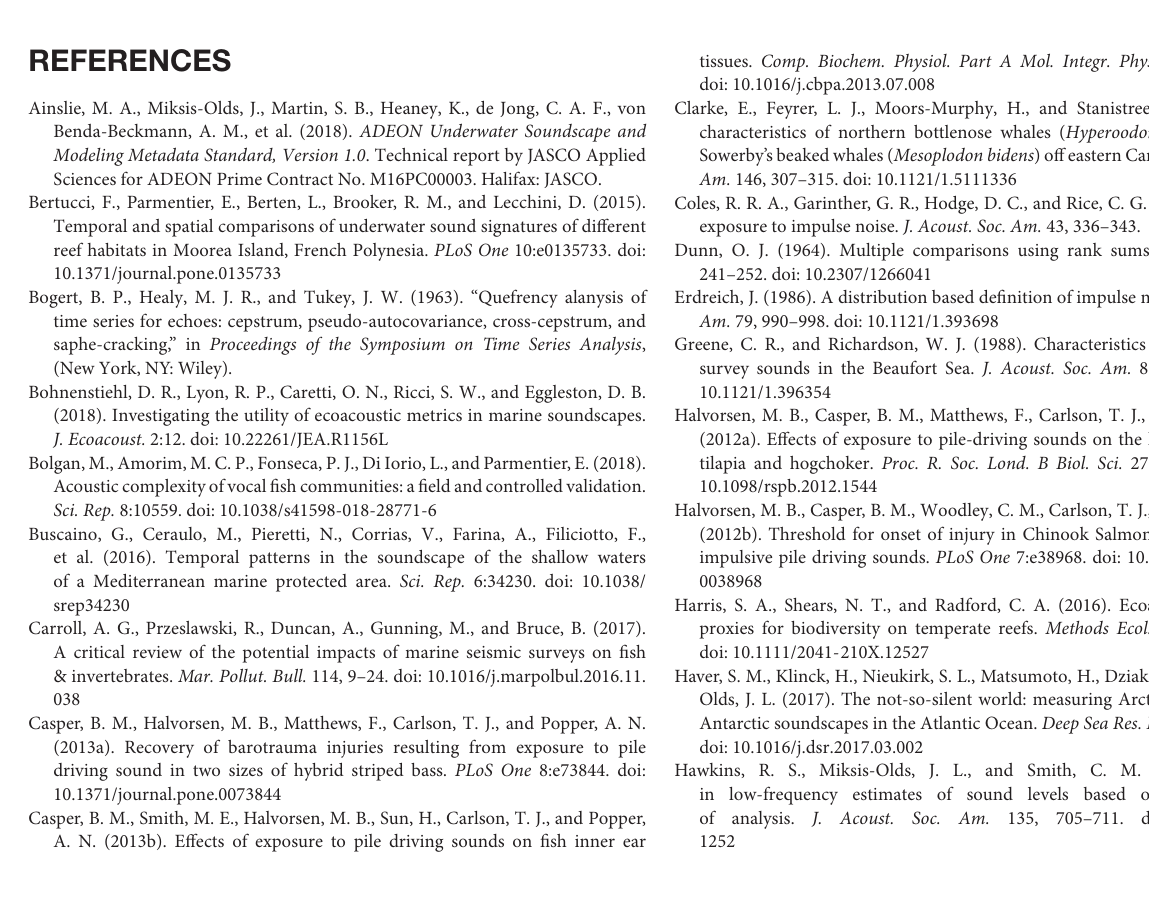
Supplementary Figure 1 | Impulsiveness comparison I2 results. (A) 1-second SPLpk plot shows pulsed fin whale vocalizations that mostly occur in the first 10-minute time window, and corresponding 1-minute (B) kurtosis and (C) crest factor values. Supplementary Figure 2 | Impulsiveness comparison I3 results. (A) 1-second SPLpk plot shows pulsed seismic survey signals that increase in repetition and amplitude from time window 1 (left) to time window 2 (right). Corresponding 1-minute (B) kurtosis and (C) crest factor values are shown for the two time windows. Supplementary Figure 3 | Boxplots of (A) cepstrum, (B) acorr2, and (C) acorr3 values corresponding to the GB4v35 dataset. Each box represents the range of metric values in a 10-minute time window comprised of metrics calculated over 1-minute time windows (each boxplot contains 10 metrics values). Red horizontal line indicates median value, outer edges of boxes represent 25th and 75th percentiles, whiskers mark boundary that contains approximately 99% of data values, and the red points are outliers. Supplementary Figure 4 | Uniformity comparison U2 results. H-index values for (A) OR and (C) GBR sites; D-index values for (B) OR and (D) GBR sites; Red horizontal line indicates median value, outer edges of boxes represent 25th and 75th percentiles, whiskers mark boundary that contains approximately 99% of data values, and the red points are outliers. Corresponding soundscape code results for (E) the D-index at ORand GBR, and (F) the H-index at OR and GBR report the median (med) and size of the 95% confidence interval